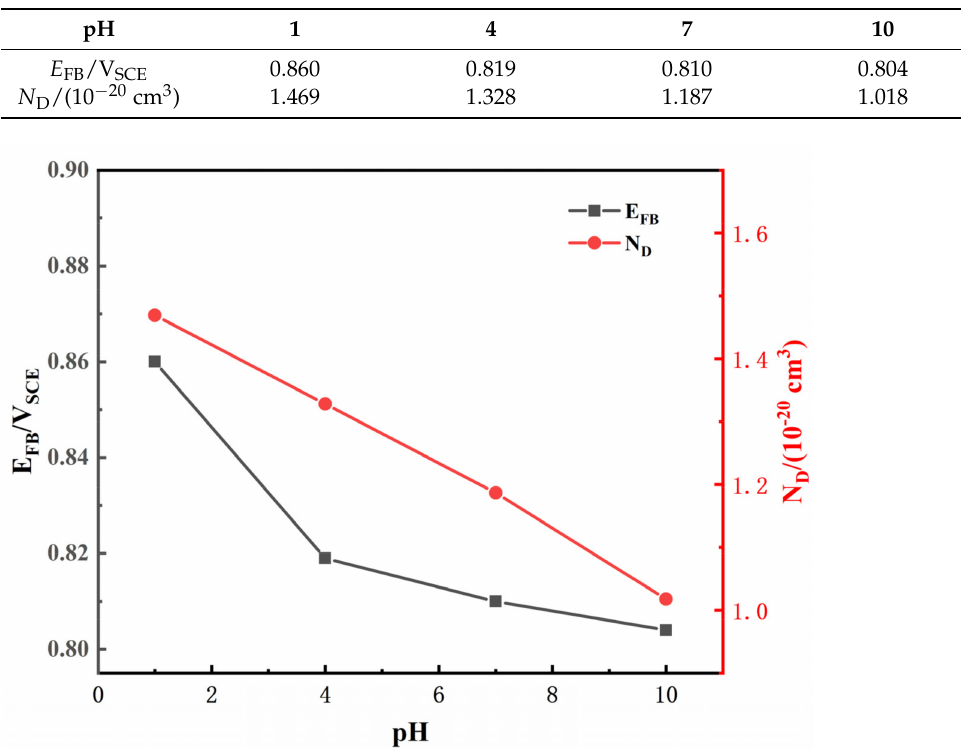
Table 3. Fitting results of Mott–Schottky curve of TA2 in simulated seawater solution with differ- ent pH.